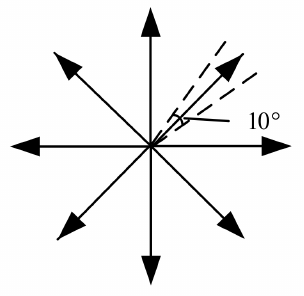
Figure 4. One of the eight